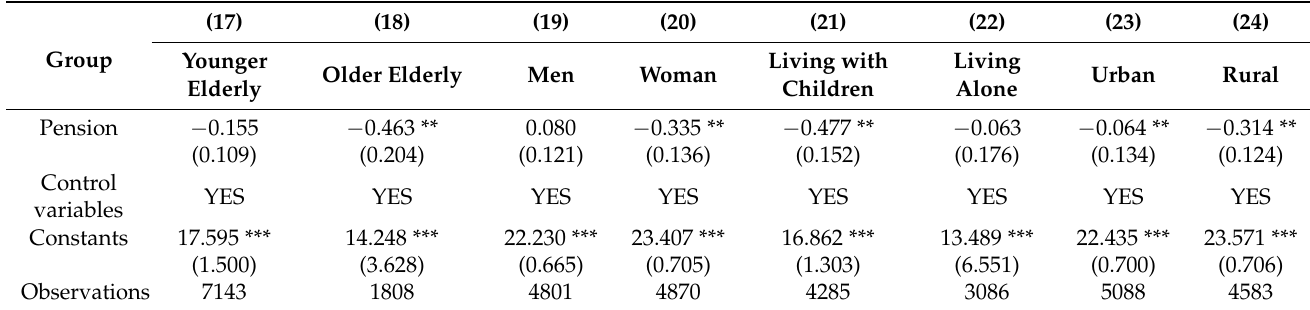
Table 5. Heterogeneity test